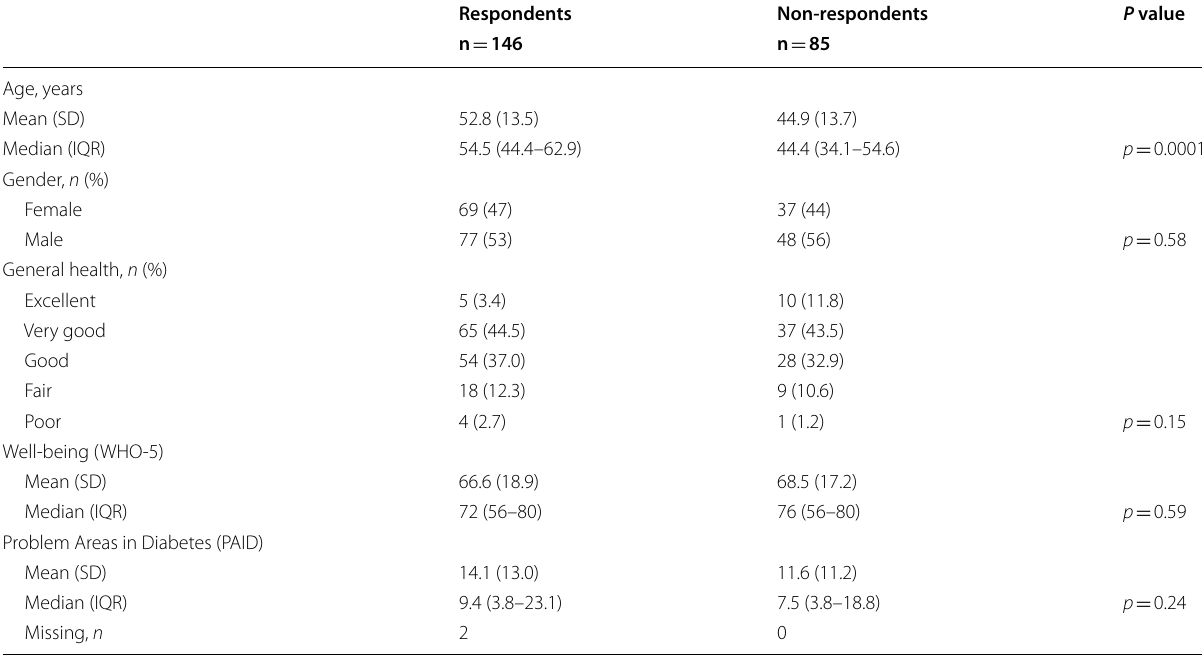
Table 1 Patients characteristics of responders and non-responders of the second questionnaire (Test 2) based on data from the annual DiabetesFlex questionnaire (Test 1), N =